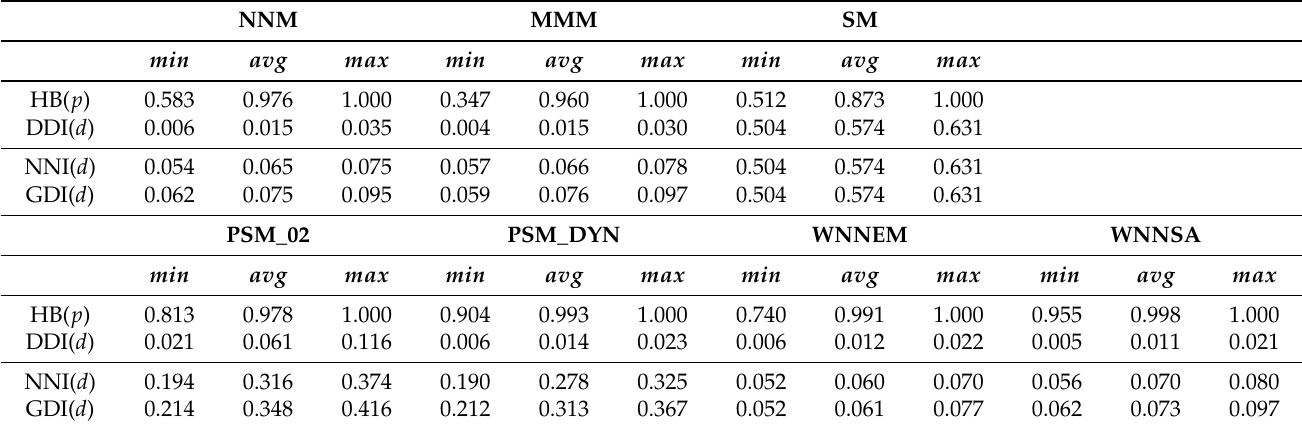
Figure 2. Similarities of the case and control groups on each attribute in Scenario I. Distributions of the Chi-square p -values were calculated separately for each covariate. Table 1. Measures for evaluating the group-level similarities of case and control groups in Scenario I. HB( p ) denotes the p -value of the Hansen and Bowers test, DDI( d ) represents the dissimilarity value of the Distribution Dissimilarity Index, NNI( d ) stands for the dissimilarity value of the Nearest Neighbour Index, and GDI( d ) is the dissimilarity value of the Global Dissimilarity Index. In the case of HB( p ), the higher value is better, while in the case of DDI( d ), NNI( d ) and GDI( d ), the lower value is